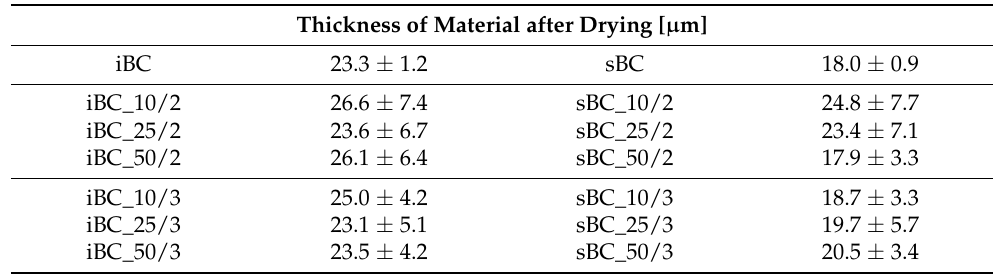
Table 2. Thickness of dry material from pure BC and GO/BC